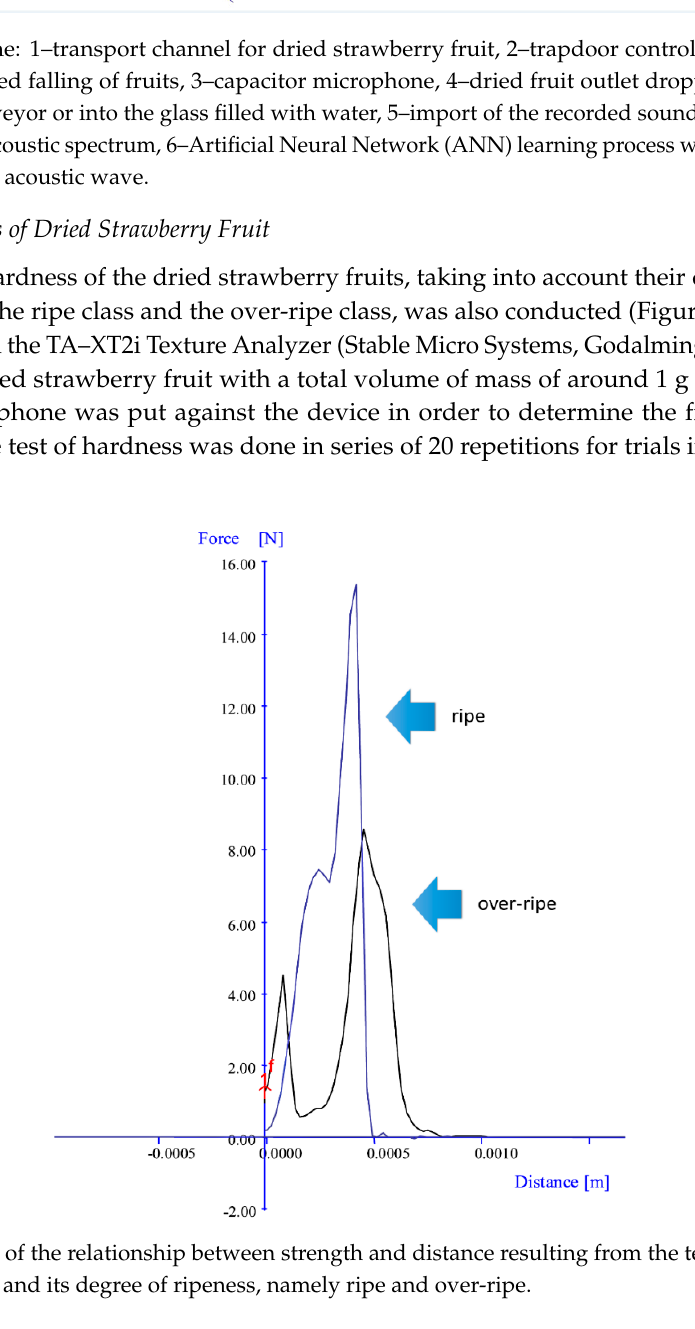
Figure 3. Scheme: 1–transport channel for dried strawberry fruit, 2–trapdoor controlling the speed of